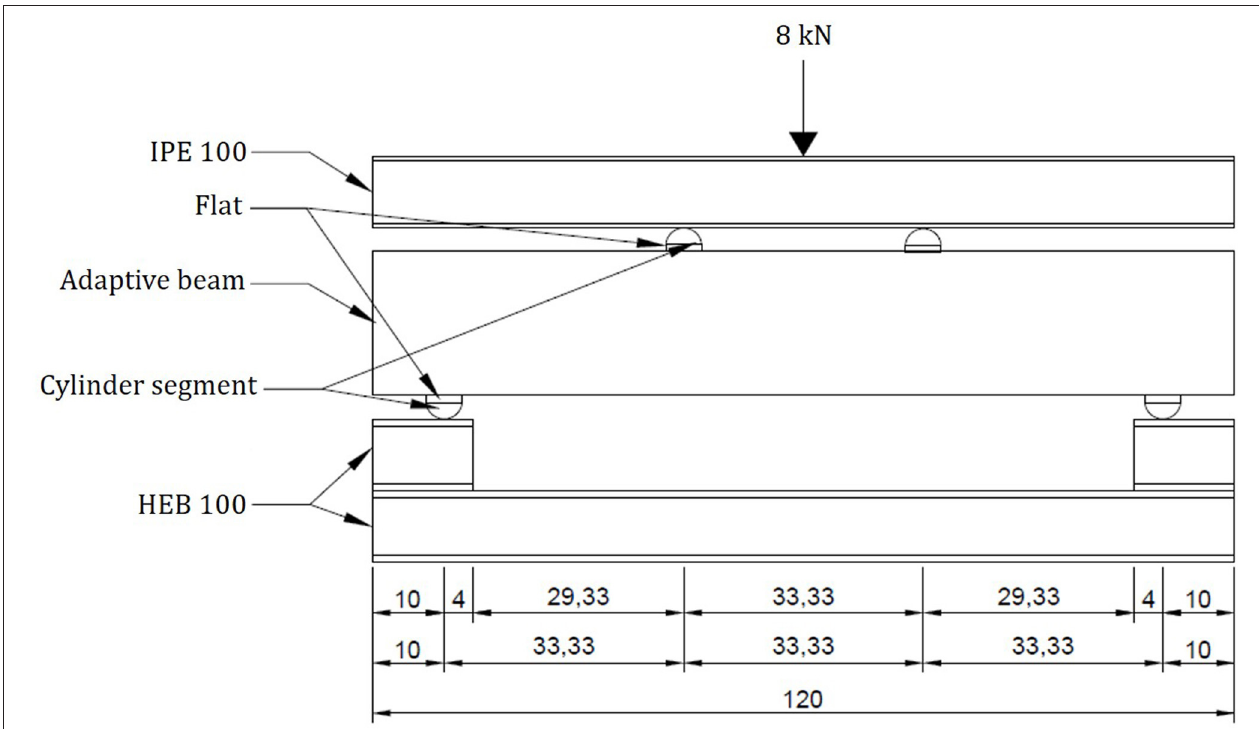
FIGURE 10 | Experimental setup for the four-point bending tests. All measurements in centimeters.